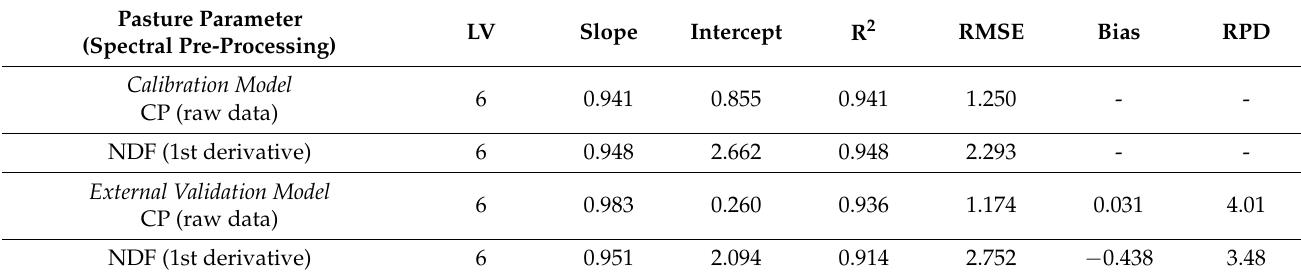
Table 3. Statistics for calibration and external validation models of crude protein (CP) and neutral detergent fiber (NDF) in pasture dry samples using near-infrared spectroscopy (NIRS) spectra and partial least squares regression (PLSR). Pasture Parameter (Spectral